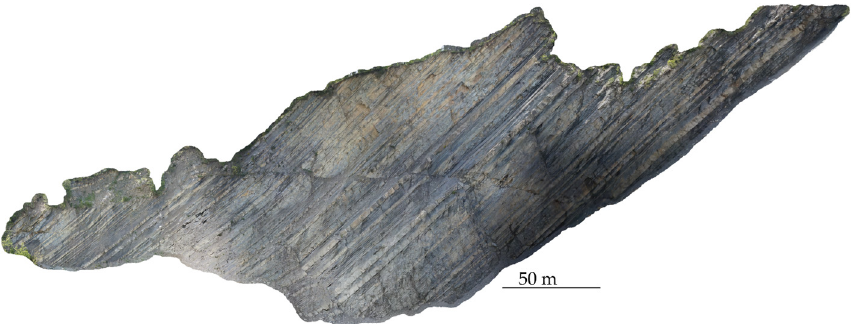
Figure 4. Orthomosaic extracted from the 2019 UAV